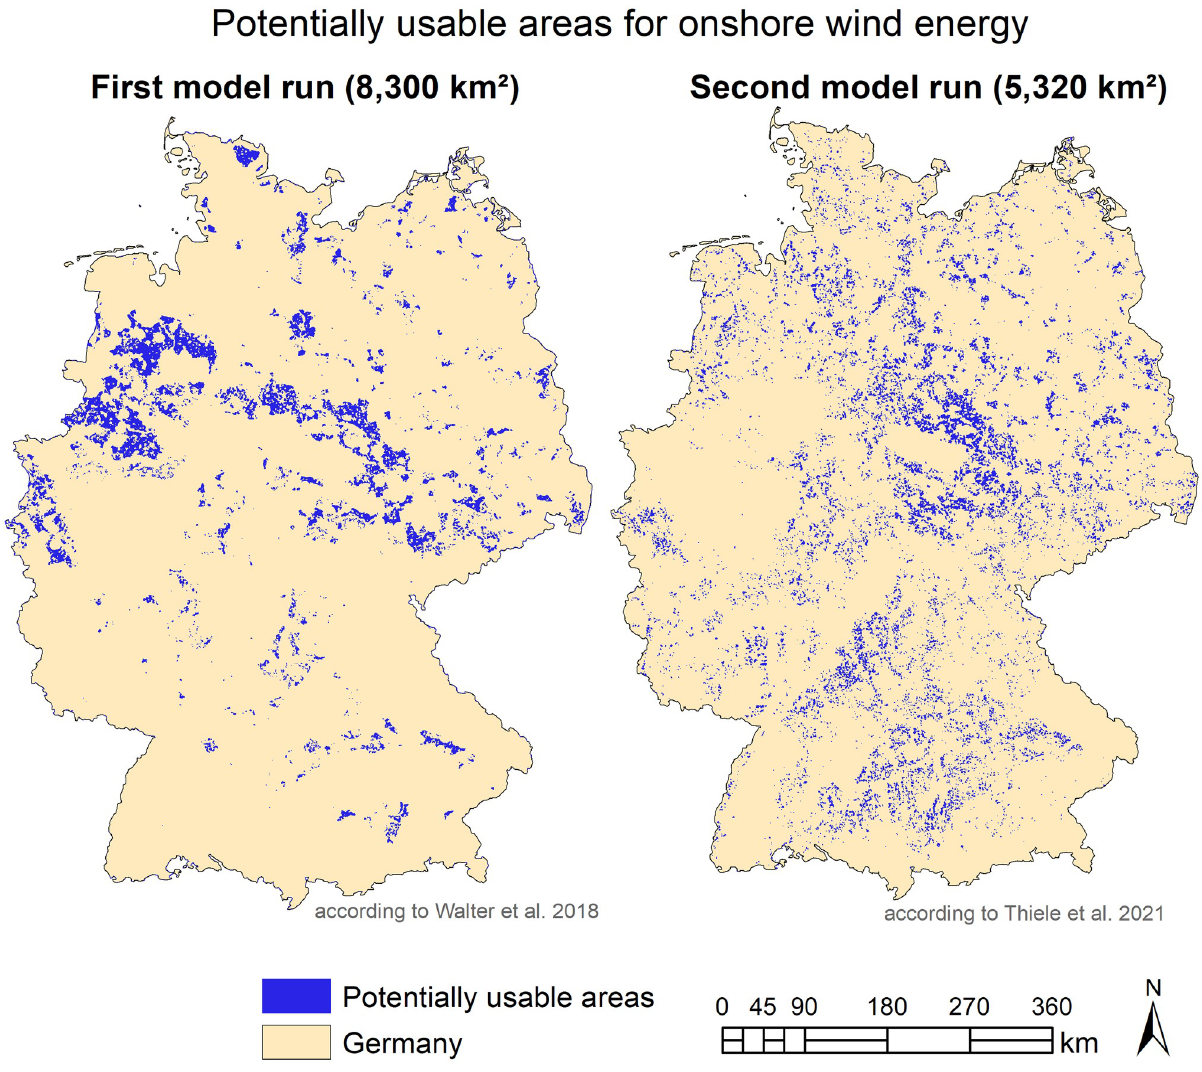
Fig 3. Comparison of the potentially usable areas for onshore wind energy (left: First model run; right: Second model run [24]). classes and railroad lines were buffered according to their number of tracks (2.5 m single-track railroad line, 4.5 m double-track railroad line) [20, 22].